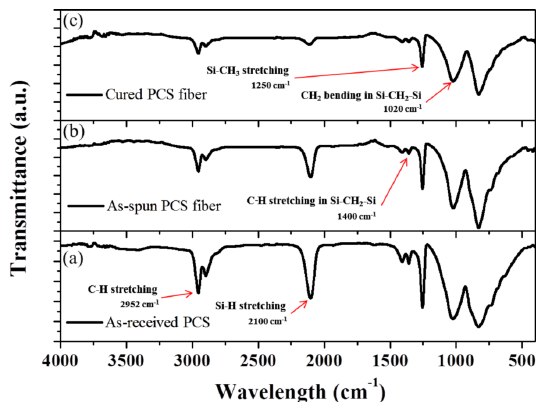
Fig. 2 FT-IR spectra of (a) as-received PCS, (b) as-spun PCS fiber, and (c) cured PCS